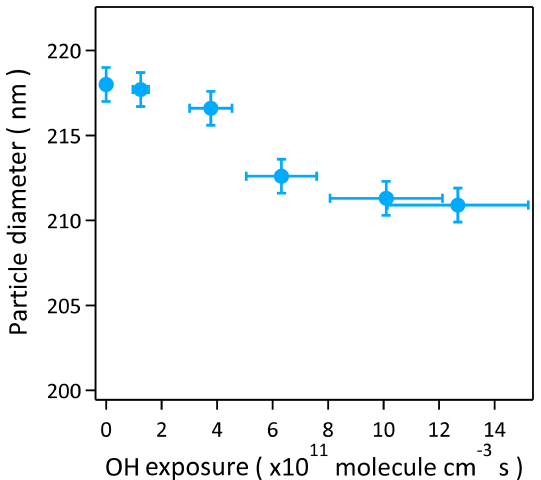
Figure 4. The surface-weighted particle diameter of sodium methyl sulfate as a function of OH exposure during heterogeneous OH ox-